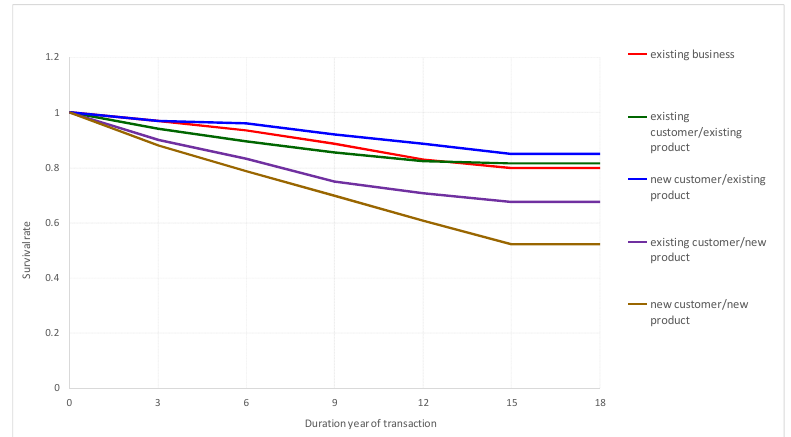
Figure 2. Survival functions of each business